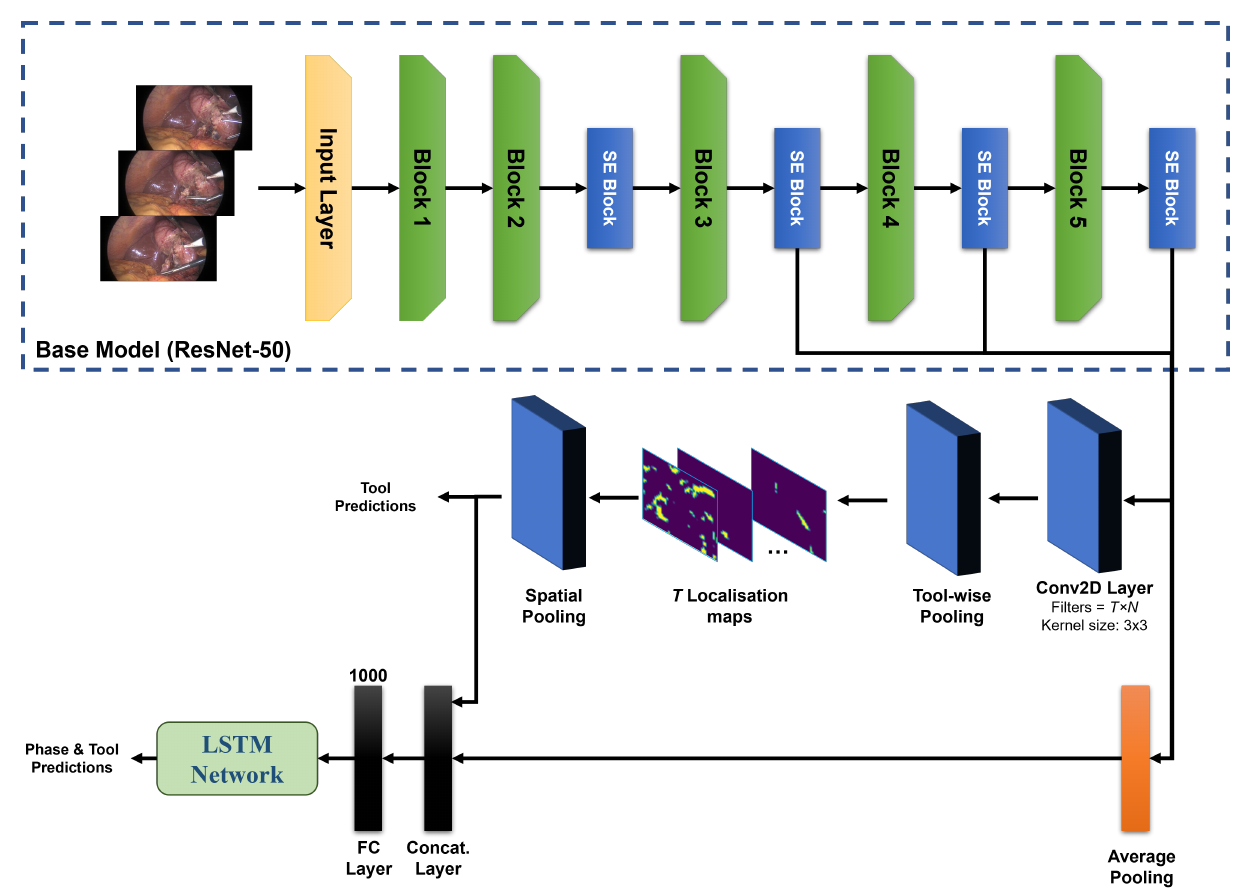
Figure 1. An overview of the proposed approach for phase recognition, tool localization, and classi- fication. SE blocks are the squeeze-and-excitation attention modules; the Conv2D layer represents the multi-map convolutional layer where T is the number of tool classes in the dataset, and N is the number of feature maps generated per